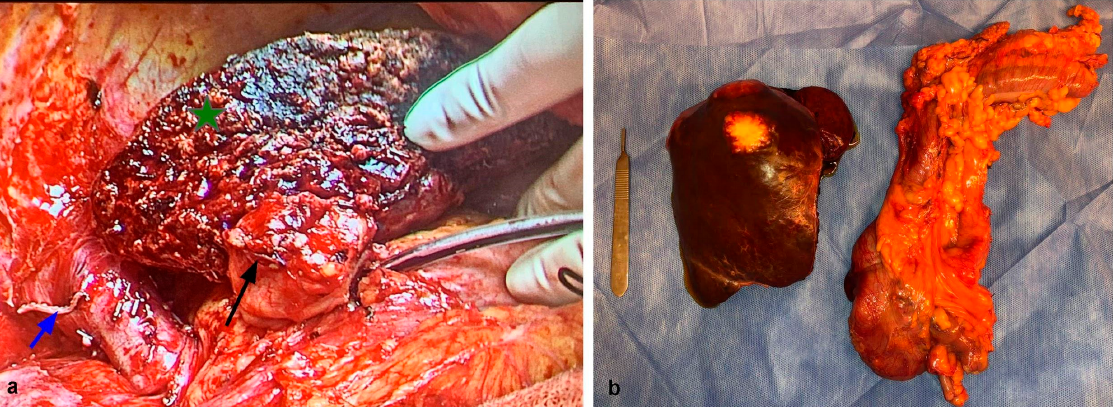
Figure 2. The patient of Figure 1 was subjected to a simultaneous approach after successful emboli- zation. ( a ) The cut-edge surface of the hypertrophied FLR is marked with the green star, the IVC with the stapled right hepatic vein (blue arrow), and the sewn-over stump of the right portal branch with a black arrow. ( b ) The surgical specimens consist of right hepatectomy and a right colectomy, with a scalpel handle for scale.